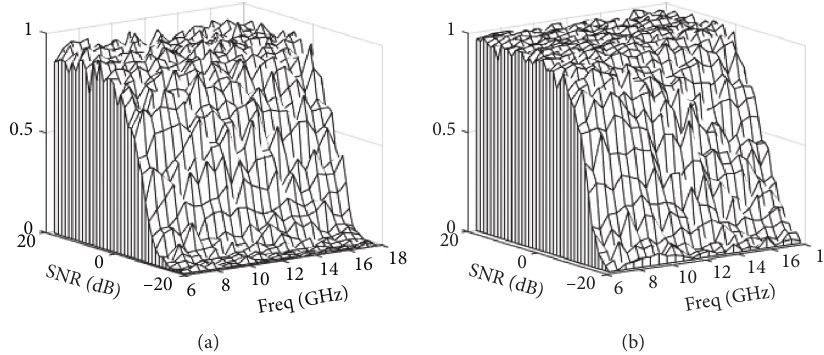
Figure 6: Array-3 probability of AoA estimation versus frequency and SNR: (a) RMSE ≤ 1 ° and (b) RMSE ≤ 5 ° , when M + 1 � 1025 for WF-1.